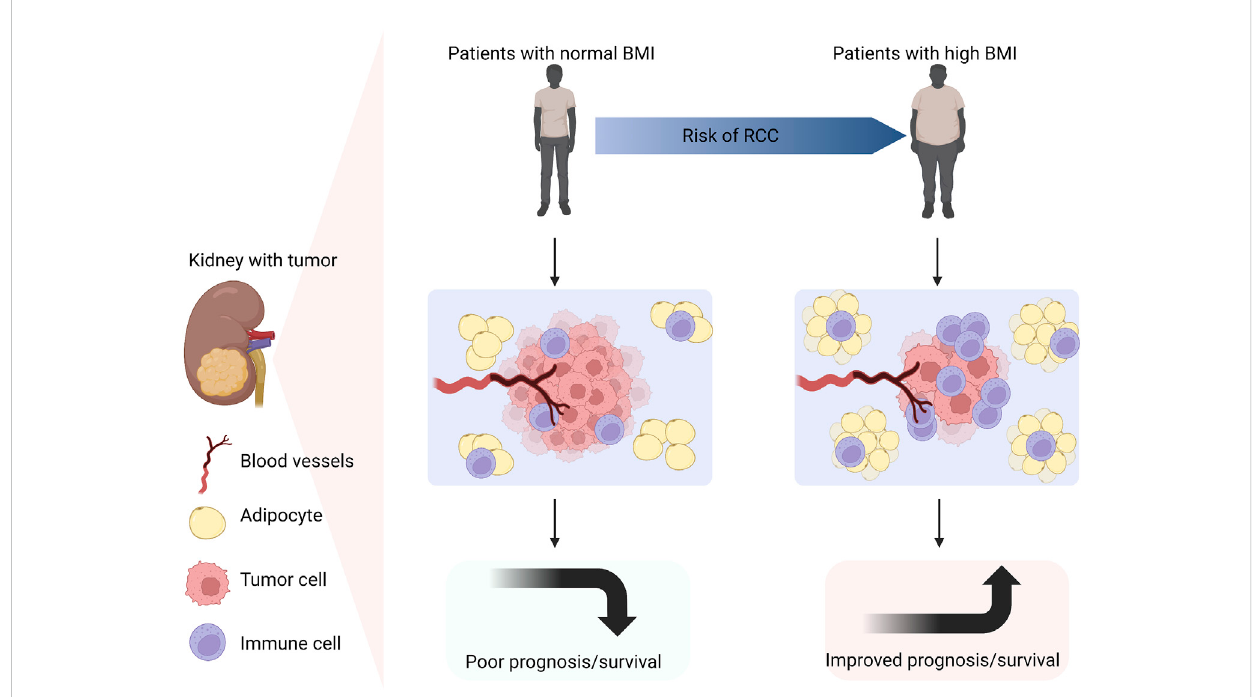
FIGURE 2 Obesity is an independent risk factor for RCC. Compared with patients with normal BMI, obese patients are more likely to suffer from RCC. Due to the lower invasiveness, higher immunogenicity and more in fi ltrative in fl ammatory cells in obese individuals with RCC, a stronger in fl ammatory reaction will occur. Thus, obese patients with RCC have better prognosis and longer survival (Created with